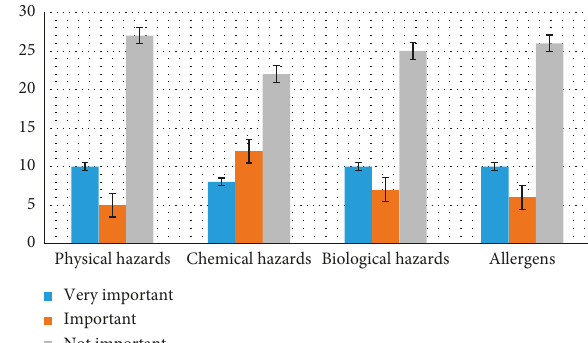
Figure 3: The level of importance attached to hazards during Ga kenkey production.